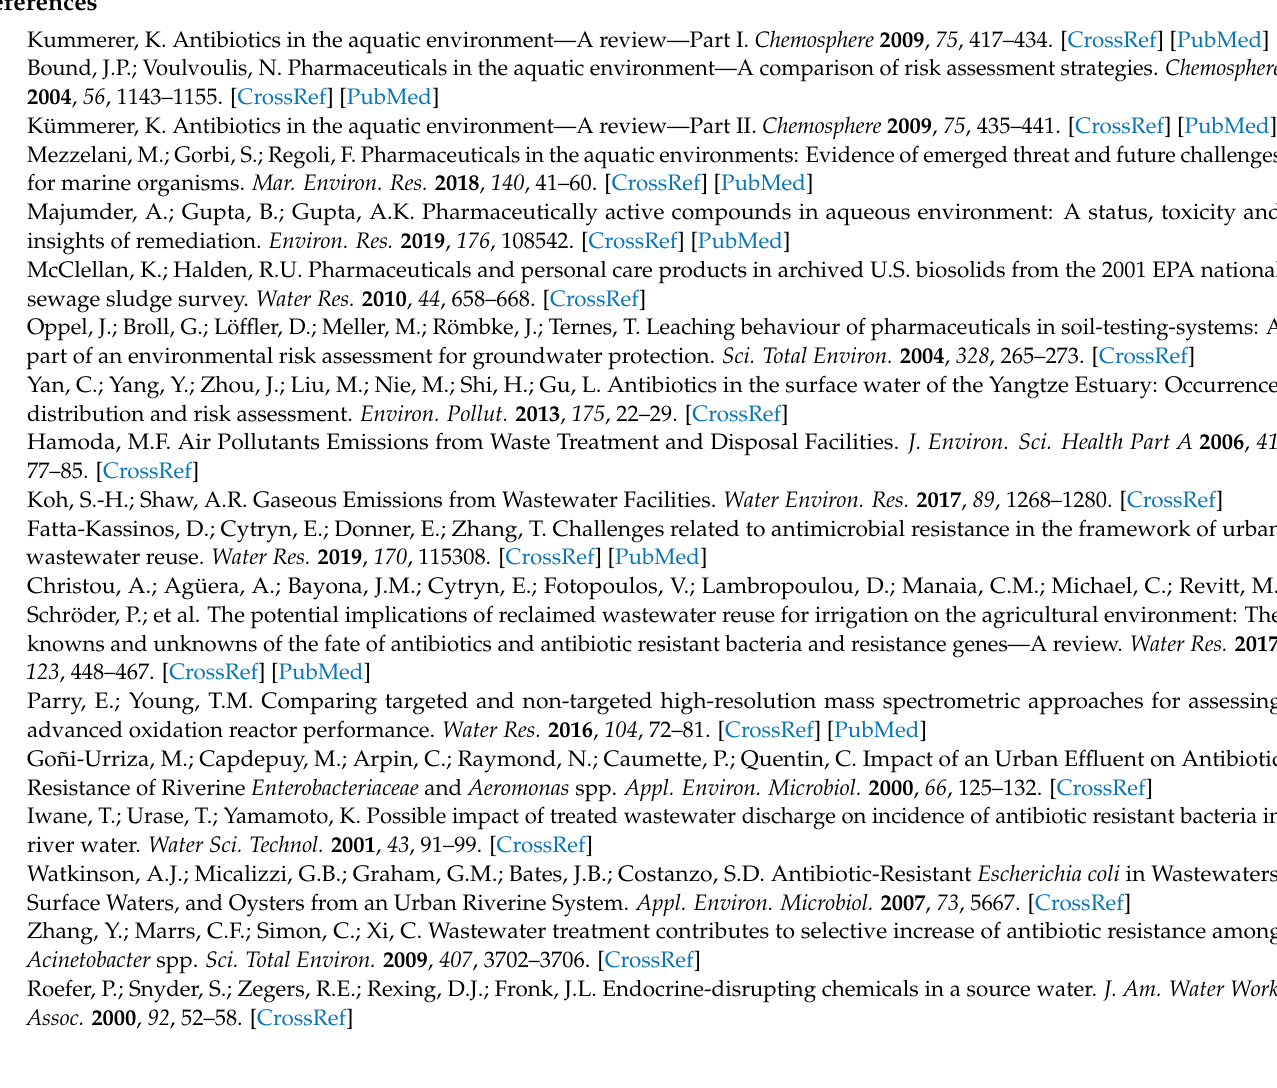
Figure S2: MS/MS spectrum of 3-methylxanthine recorded in the positive ionization